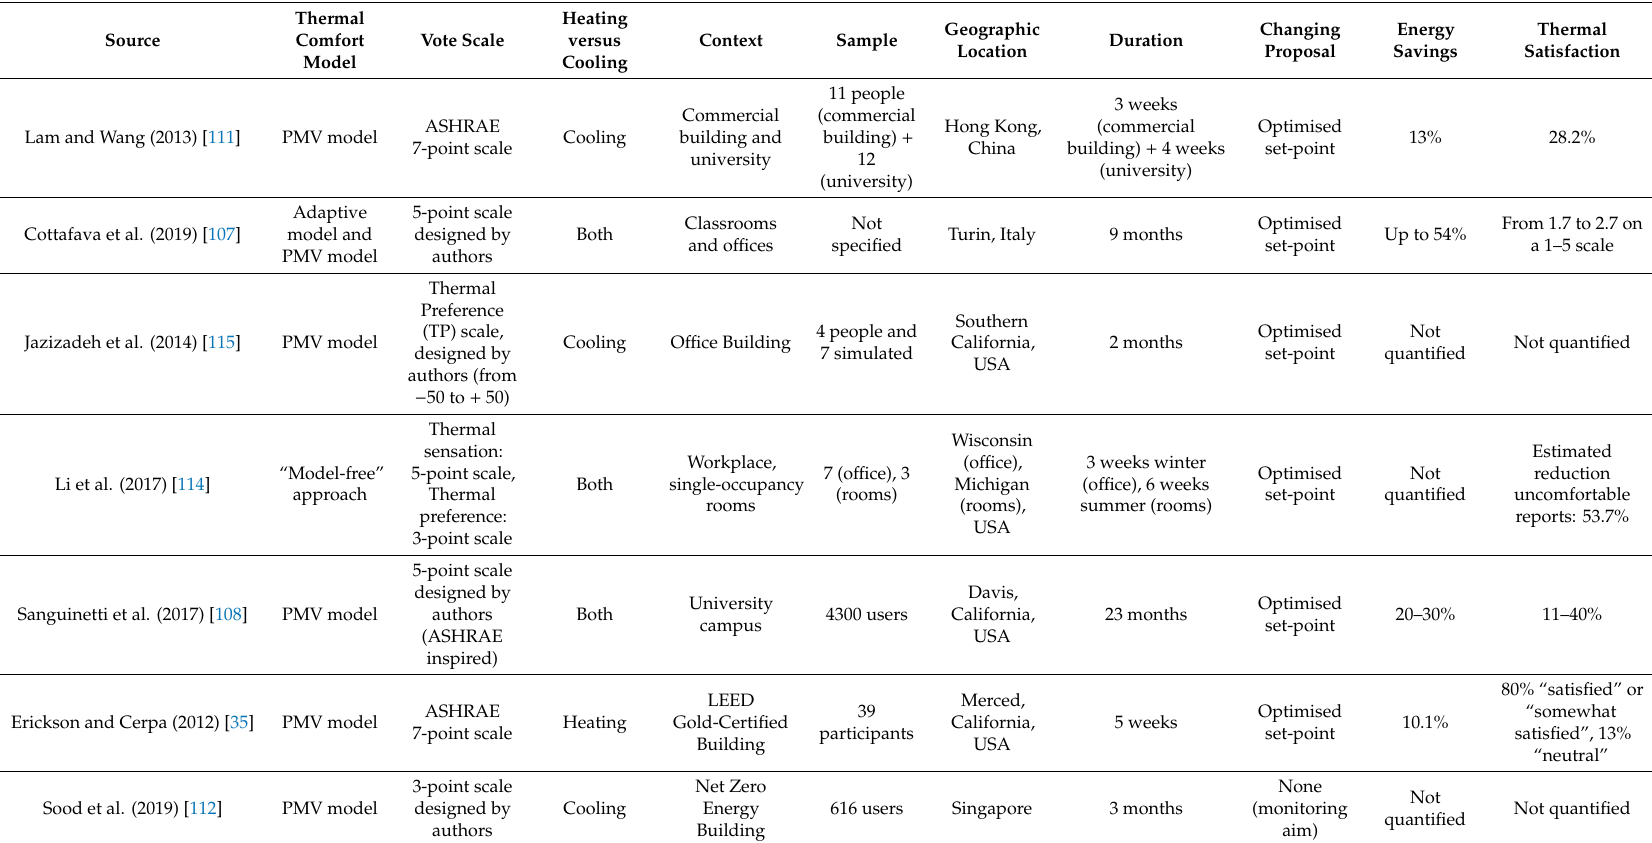
Table 4. Main contributions using Participatory thermal